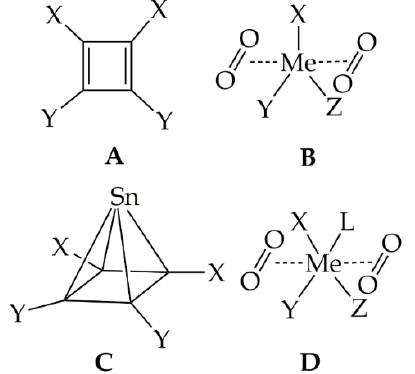
Fig. 4. Two pairs of allotomic isentropic particles. Explanations are in the text. Chemical nature of the particles: A is a derivative of cyclobutadiene, B and D are heteroligand metal complexes with molecular oxygen, C is an organotin compound with nonclassical arrangement of the atoms. Though compound C seems deliriously exotic, its analogues have been synthesized [18] .